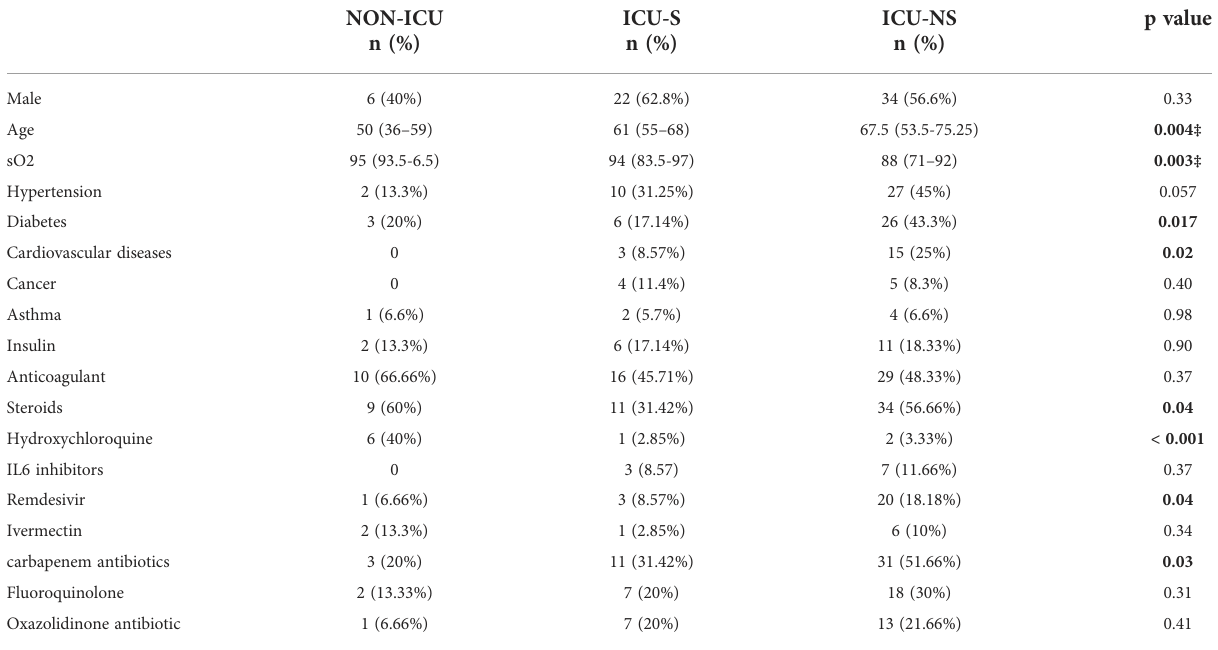
TABLE 2 Demographic and clinical characteristics of the